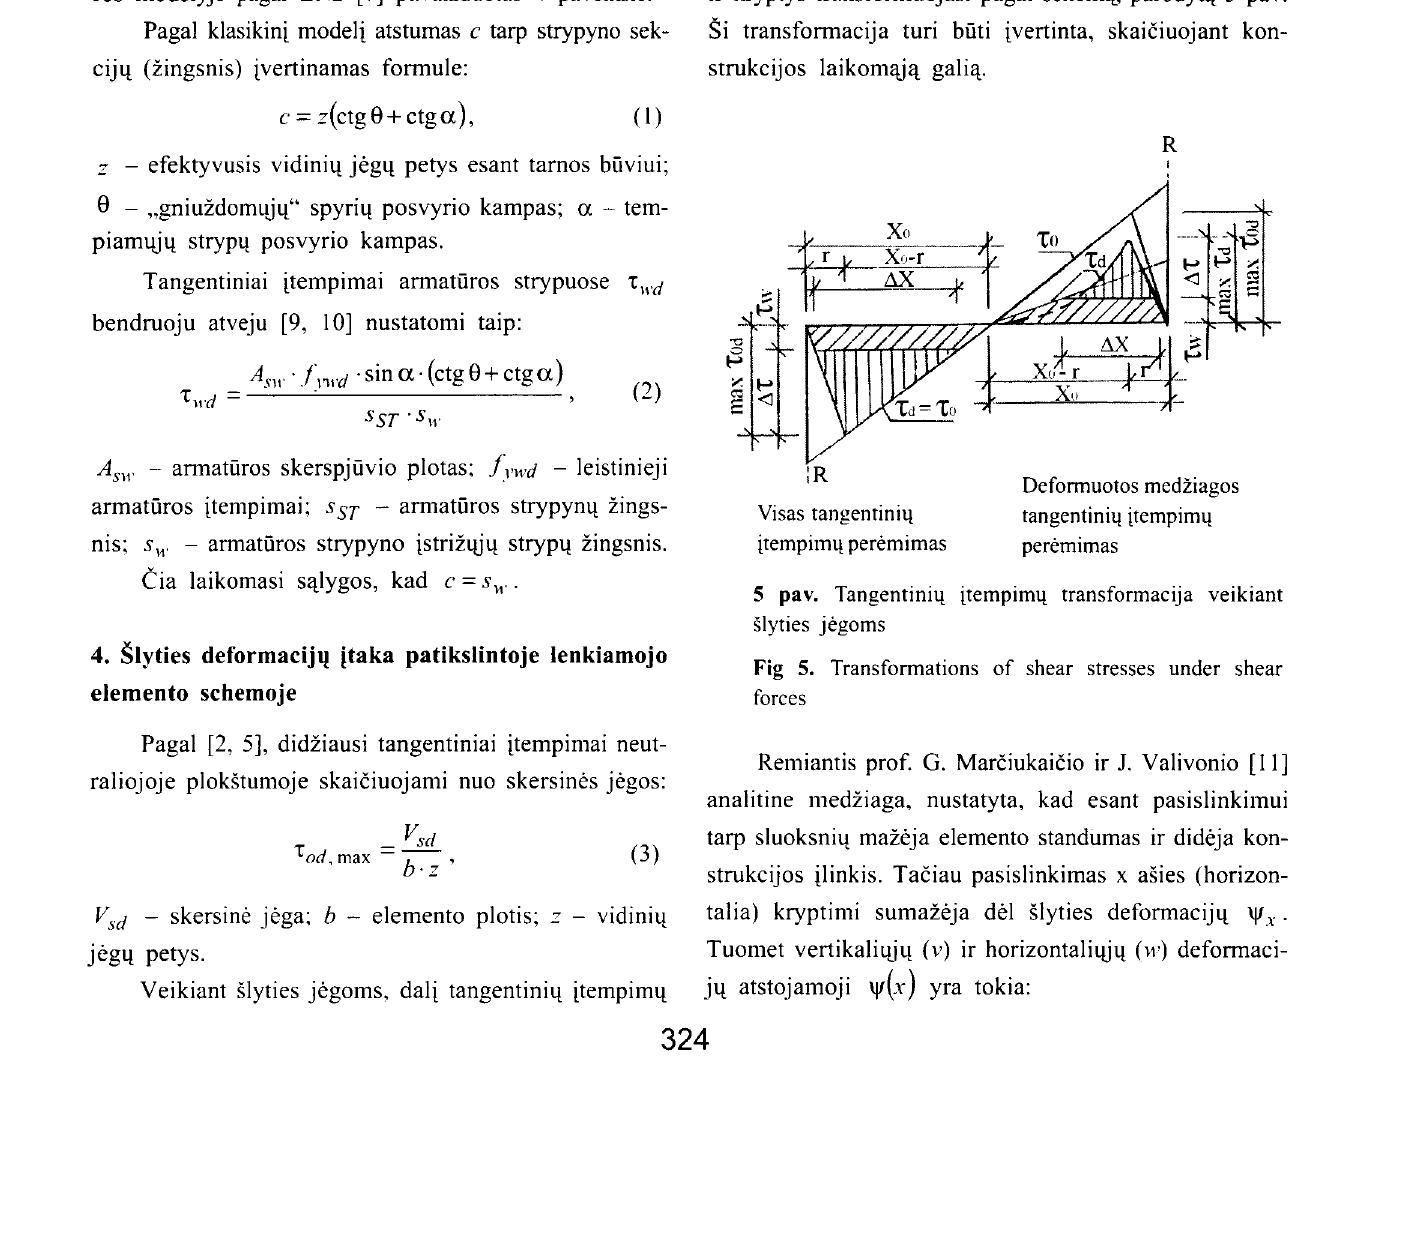
z - efektyvusis vidinil! jegl! petys esant tarnos buviui; e - ,gniuzdomujl!" spyril! posvyrio kampas; a - tem piam4.il! strypl! posvyrio kampas. Tangentiniai itempimai armatliros strypuose 't".d